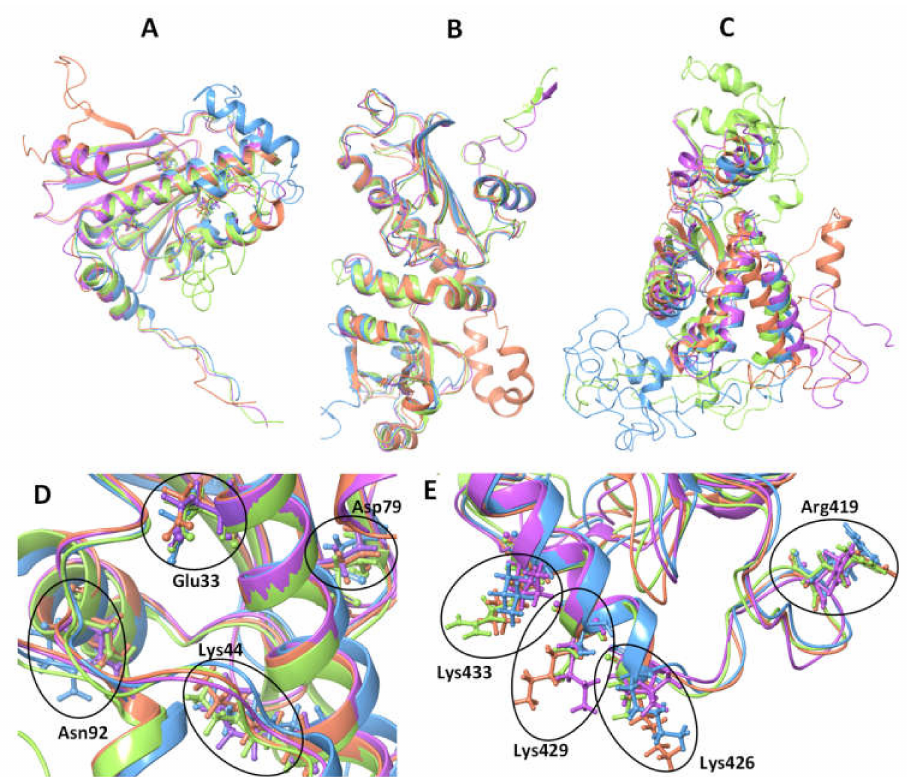
Figure 3. Superimposed domains and catalytic loop residues of the four parasite Hsp90 proteins. The 3-dimensional models of the four parasite Hsp90 proteins are superimposed to show catalytic residue structural conformation conservation. Catalytic residues of the other Hsp90 paralogs are thought to interact with the γ phosphate of ATP, enabling its hydrolysis. ( A ) The NTDs of the four parasite proteins. ( B ) The MDs of the four parasite proteins. ( C ) The CTDs of the four parasite proteins.